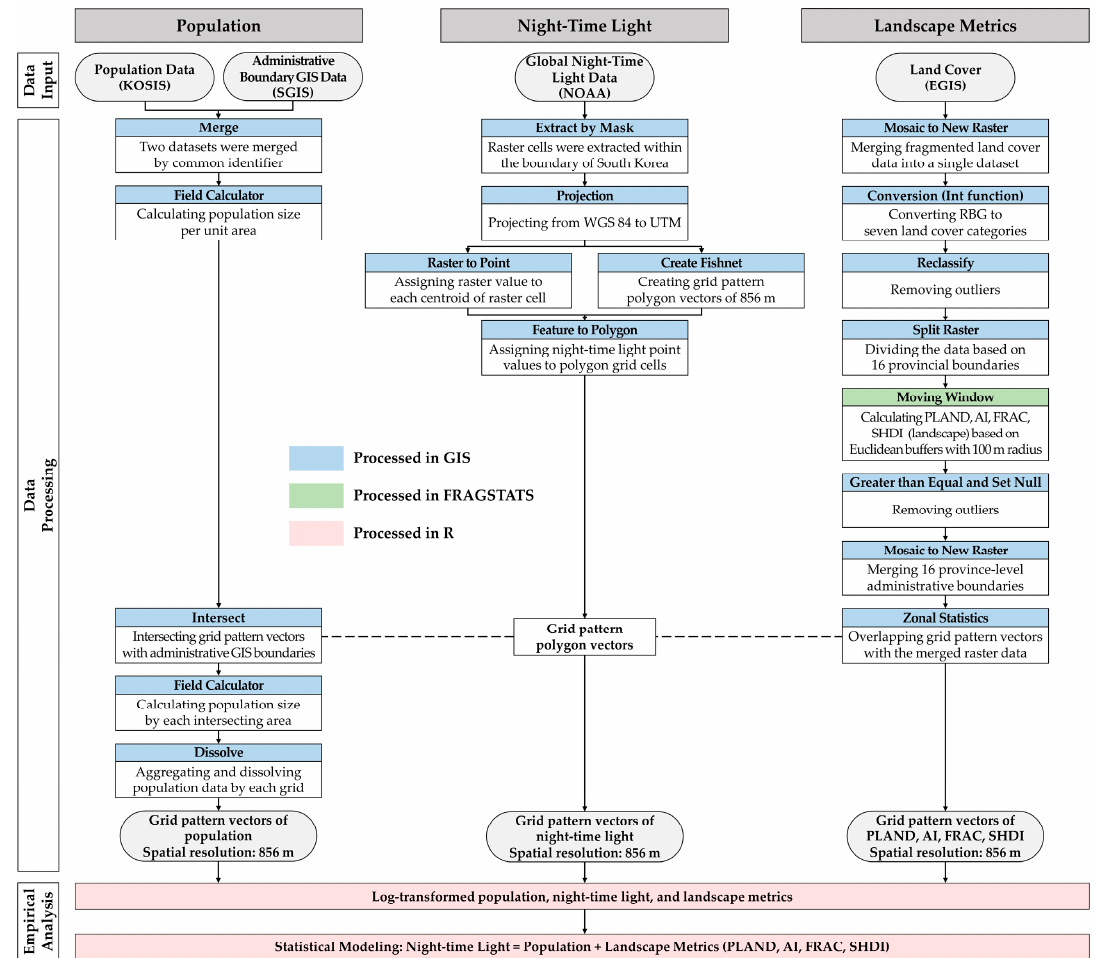
Figure 4. The protocol for processing three spatial datasets. Vector grid cells (856 m × 856 m) were created to integrate different types of data. Most data management procedures were conducted in ArcGIS. Landscape metrics were calculated in FRAGSTATS using moving window techniques.